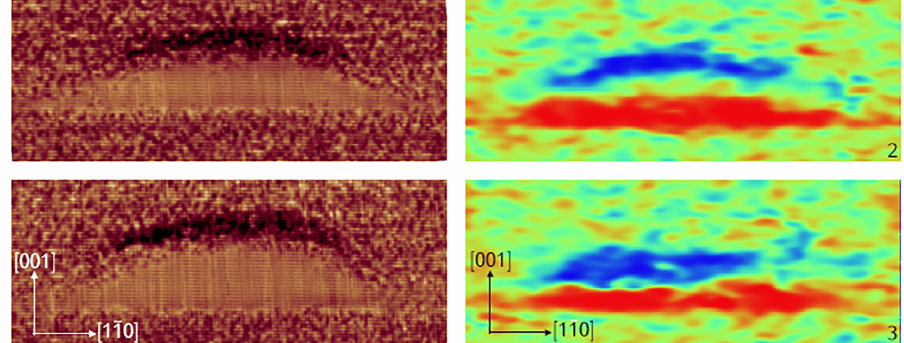
Figure 11. 75 × 28 nm 2 filled-state topography images of 2 different DEQDs grown from 5 ML of Ga ( left panel ). 60 × 30 nm 2 2D Al concentration maps ( right panel ) taken on one QD grown from 3 ML of Ga at different positions. The color scale is linear from 0% (red) to 35% (blue) of Al. An Al-rich region is present above the QD. Adopted from Ref.